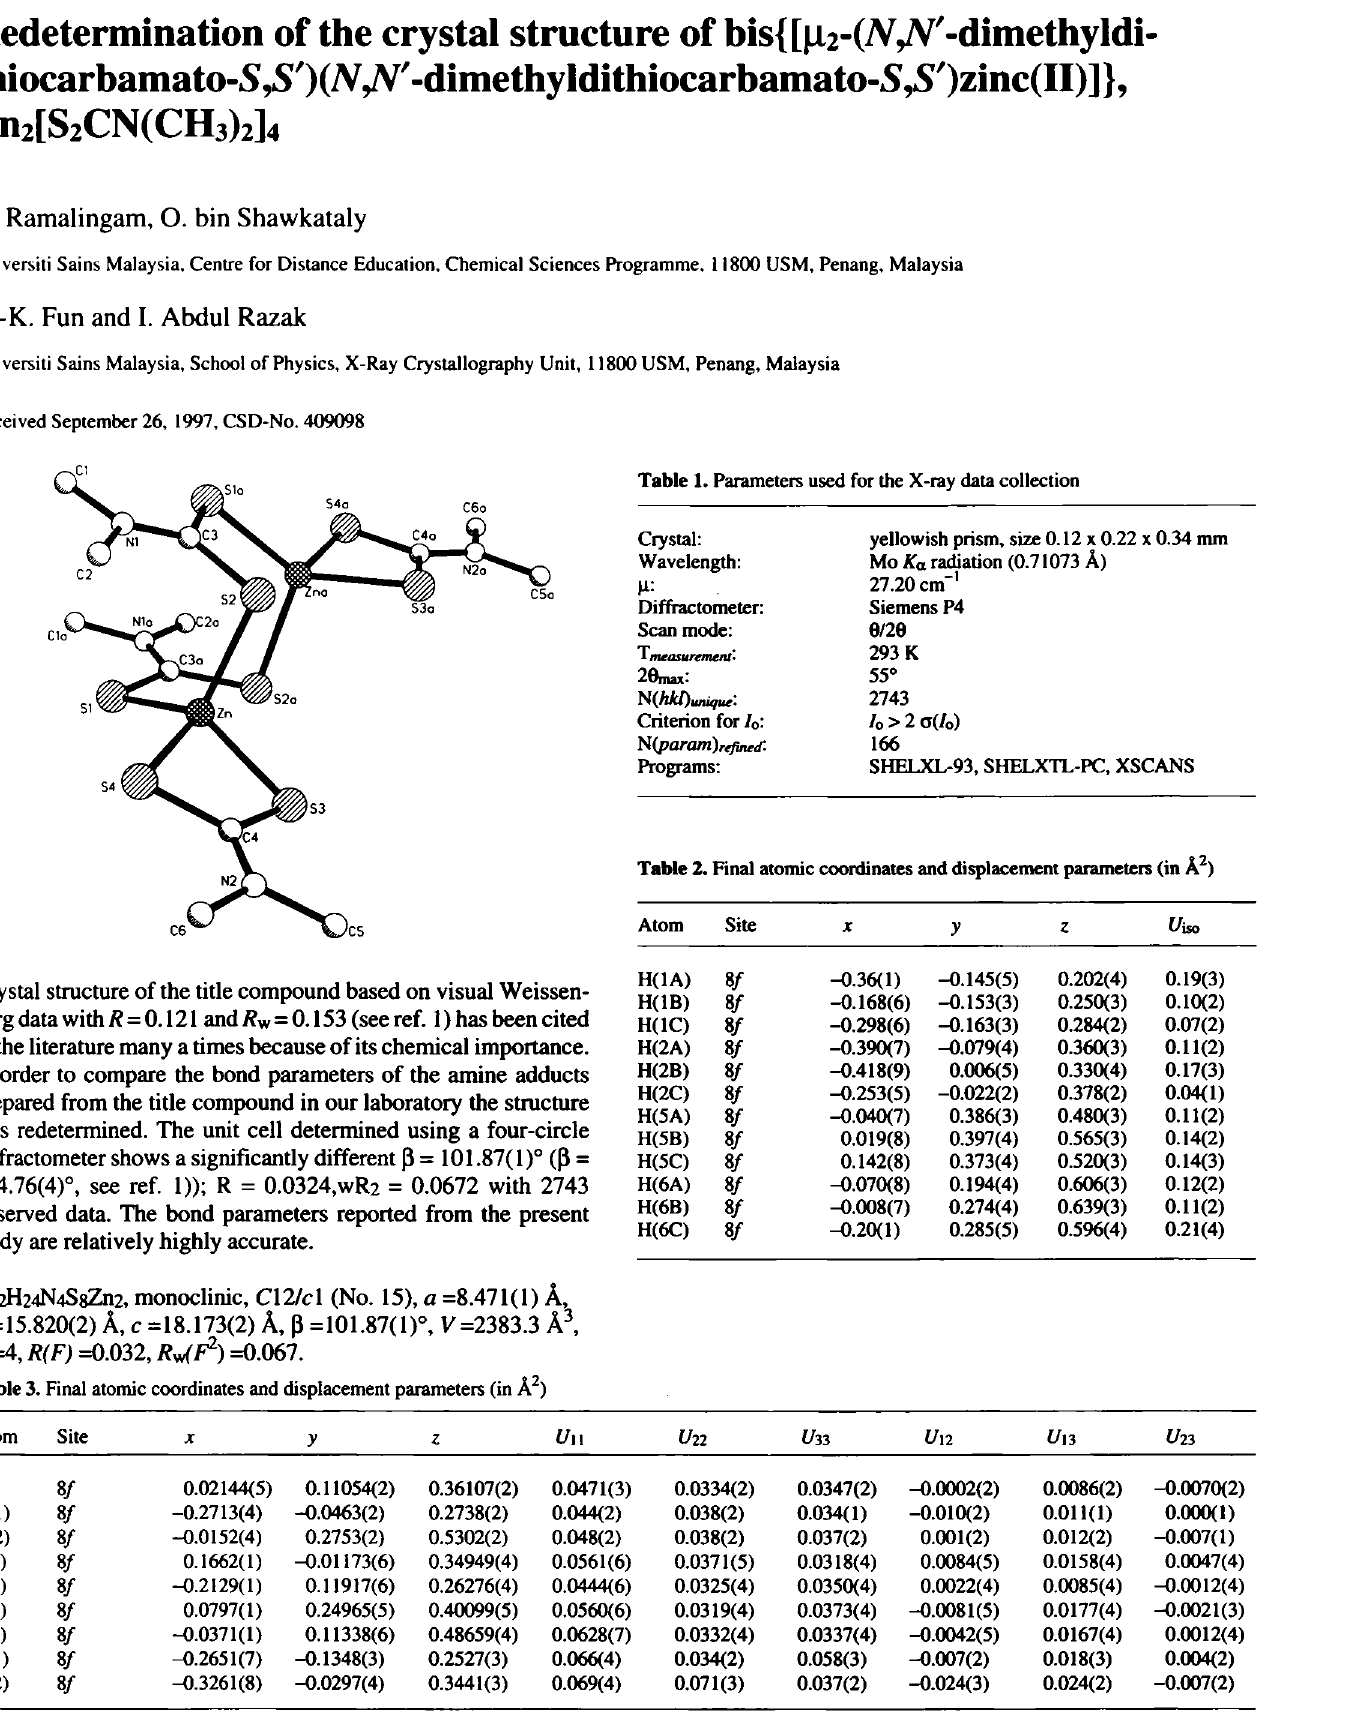
Table 1. Parameters used for the X-ray data collection Crystal: